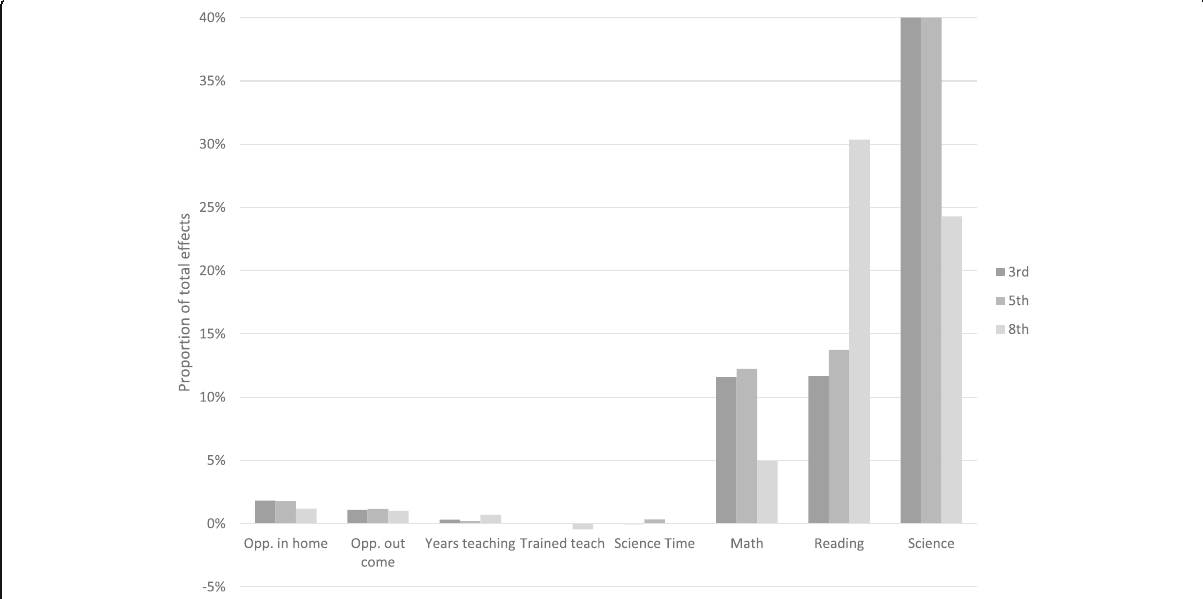
Fig. 3 Contributions of each mediator to the education gap (Bachelor ’ s vs. no high school) in science